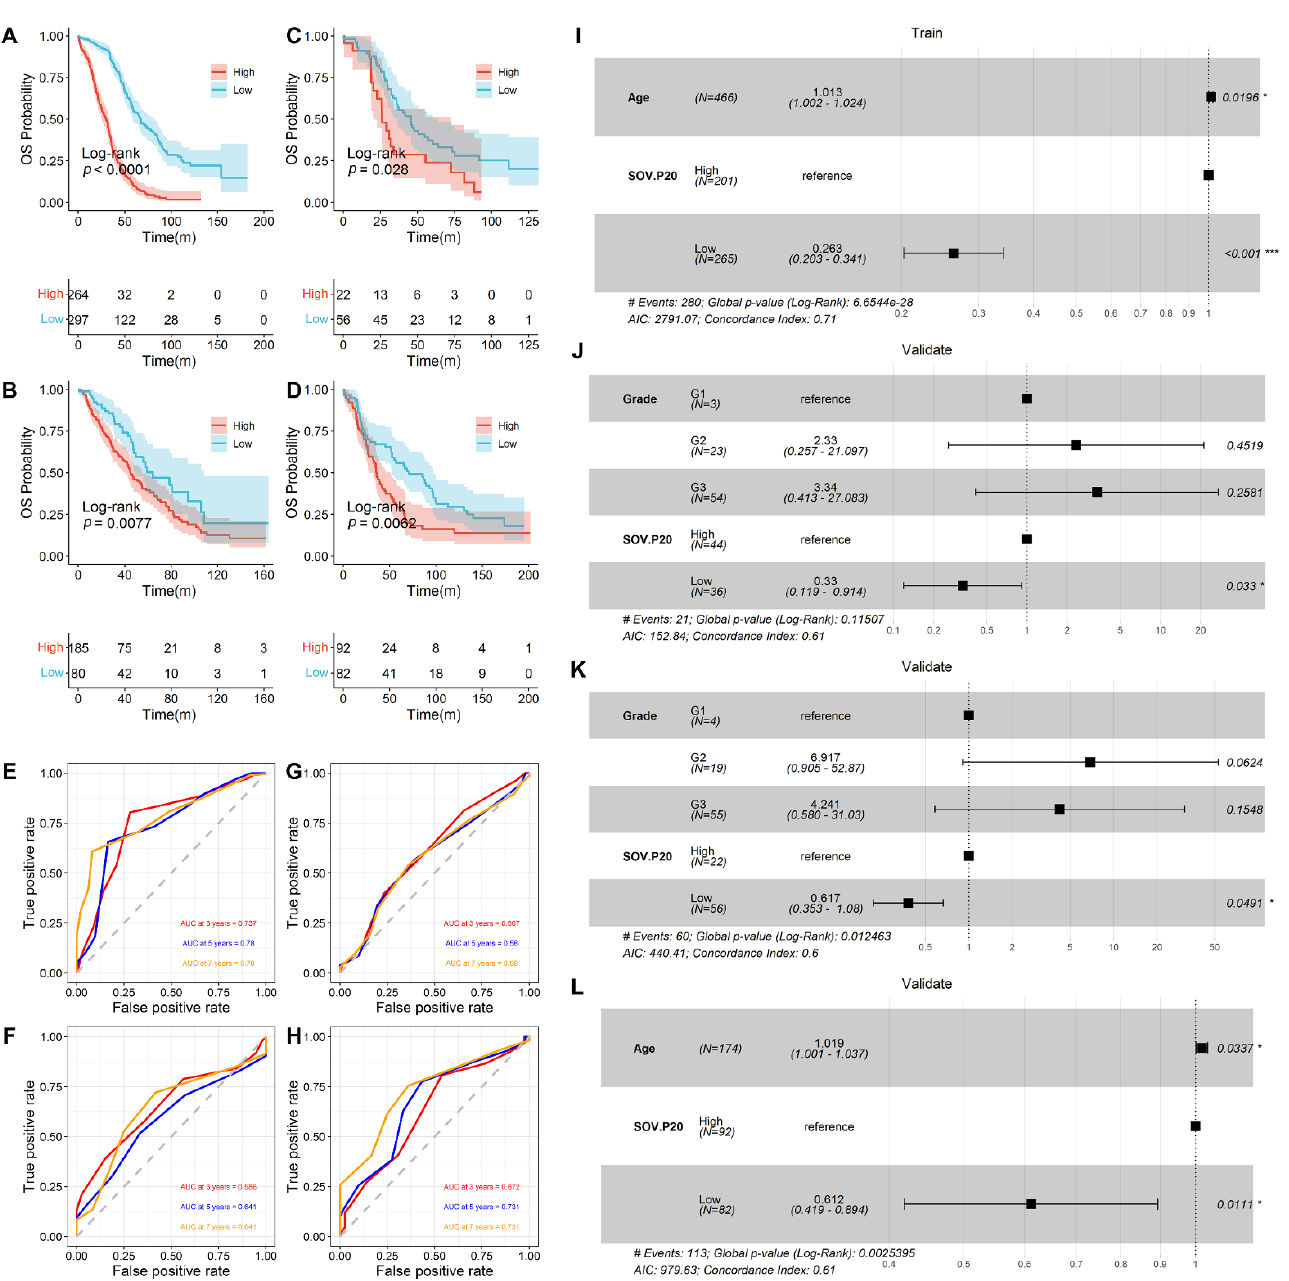
Figure 2. SOV-P20 predicts the high- and low-risk stratification of overall survival. ( A – D ) Kaplan– Meier overall survival curves of serous ovarian cancer patients in the training and three validation datasets; ( E – H ) the time-dependent ROC curves of SOV-P20 predict the 3-, 5-, and 7-year overall survival in the training and three validation datasets; ( I – L ) multivariate Cox regression analysis forest plots in the training and three validation datasets, * p < 0.05; *** p < 0.001. Since the overall survival time of patients exceeded five years, the AUCs of SOV-P20 for 3, 5, and 7 years were calculated. The mean AUC was 0.756 in the training set, while in the three validation datasets, the mean AUCs were 0.590, 0.630, and 0.680 (Figure 2E– H), respectively, indicating a potential predictive value of the SOV-P20 biomarker.